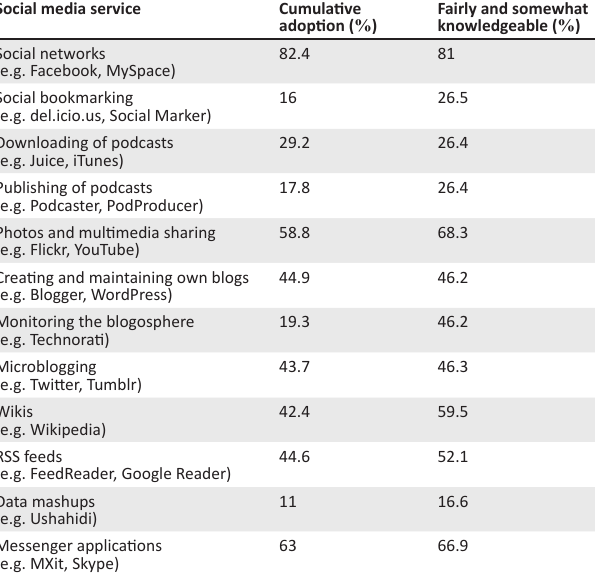
Table 1: Adoption of Web 2.0 services reflect civil society organisations’ knowledge of